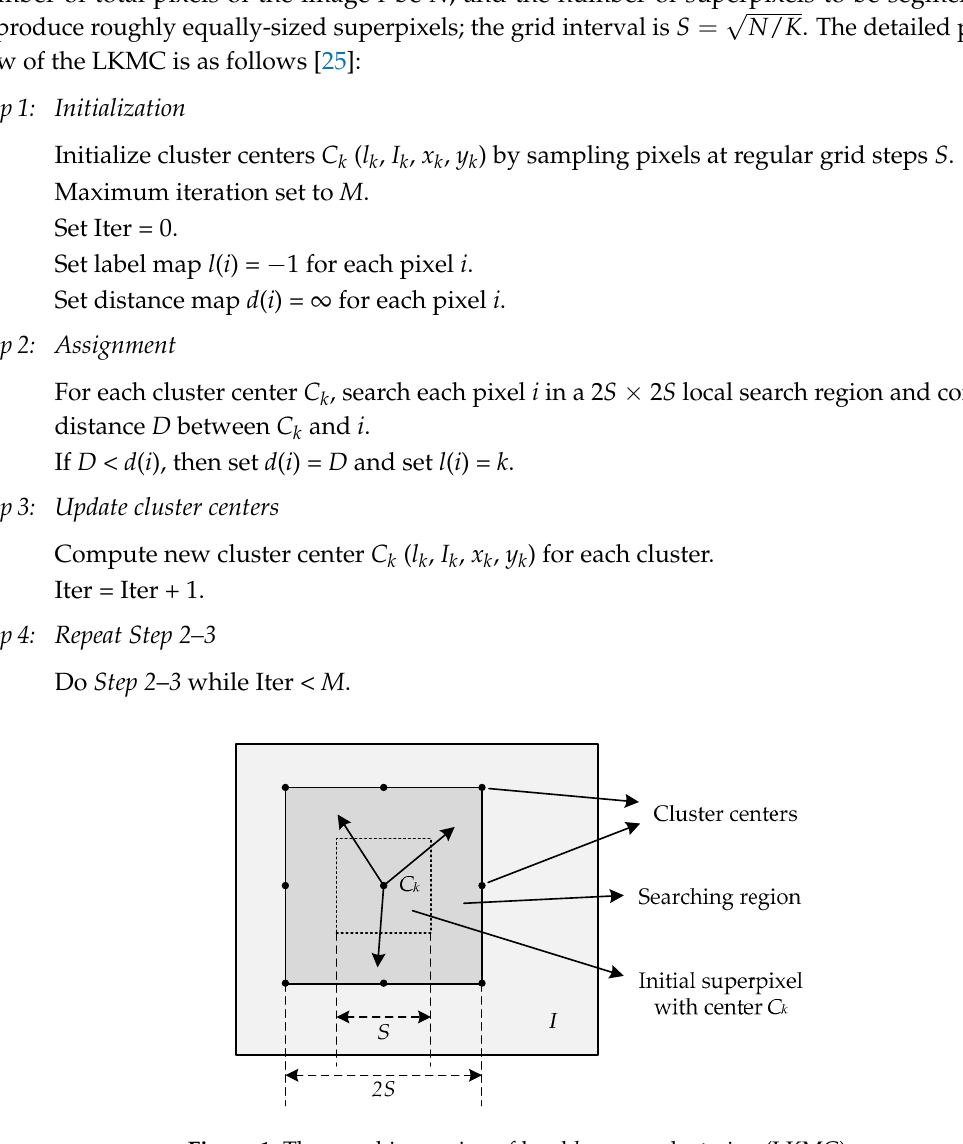
Figure 1. The searching region of local k -means clustering (LKMC).